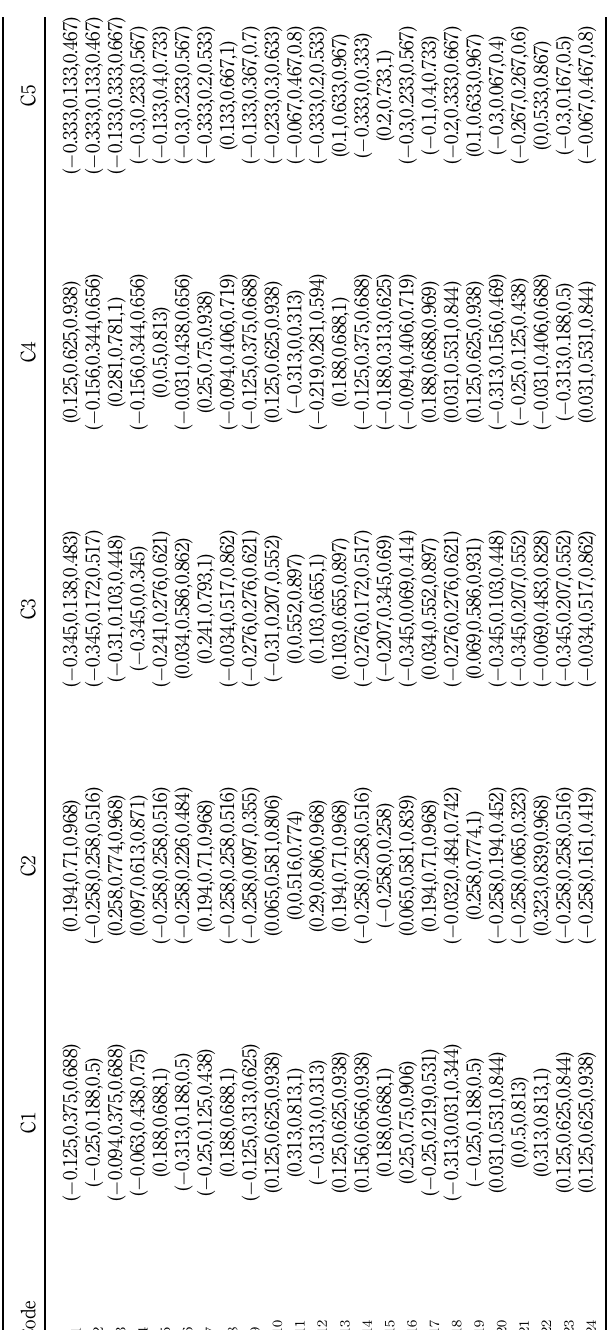
Table 6. The normalized fuzzy decision